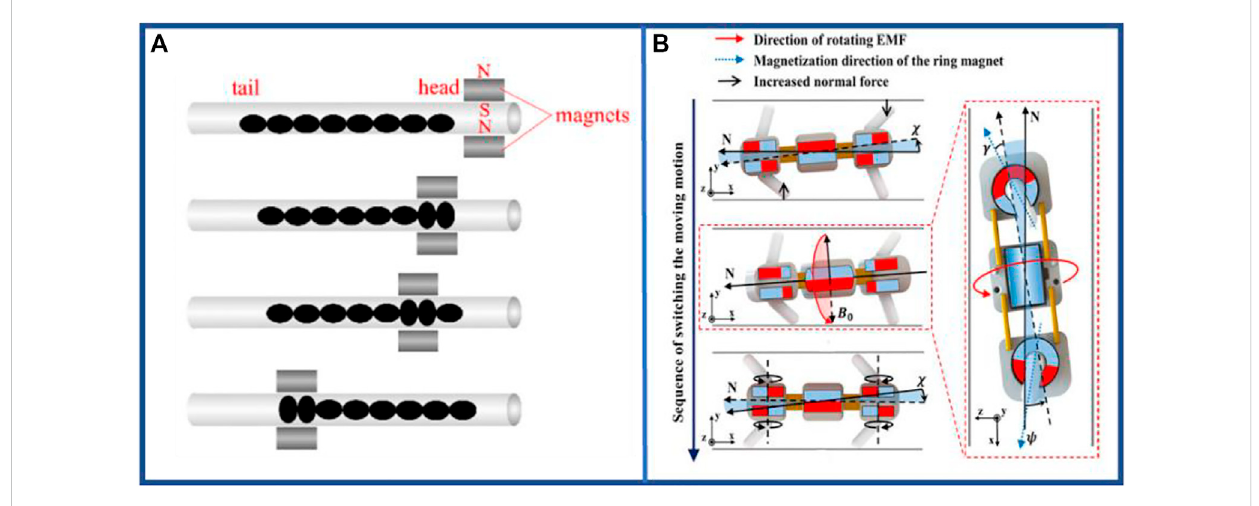
FIGURE 15 Examples of magnetic-driven multi-segment earthworm-inspired soft robot. (A) Mechanism of peristaltic locomotion with magnetic poles executing motion (You et al., 2021). Reproduced from Ref. (You et al., 2021). with permission. (B) Sequence to reverse motion direction by rotating the magnets (Jang et al., 2017). Reproduced from Ref. (Jang et al., 2017). with permission.